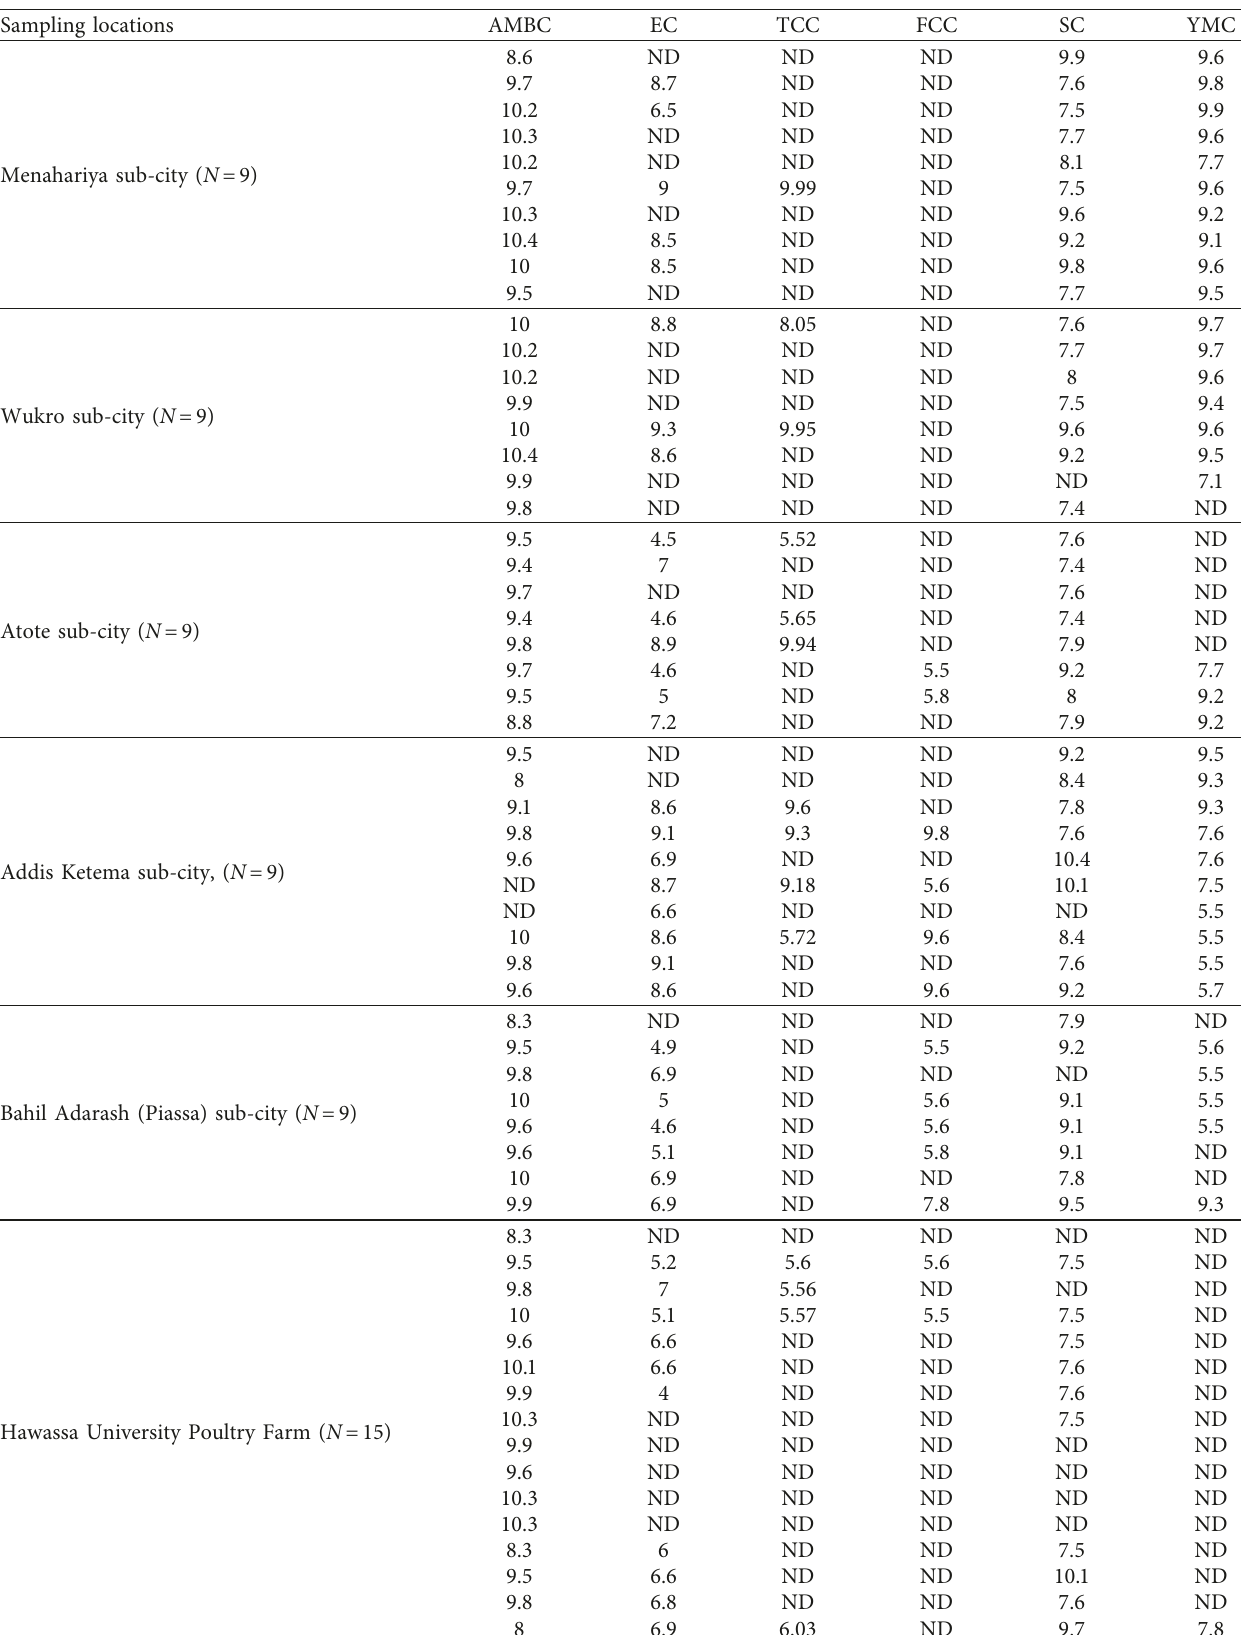
Table 4: Mean microbial loads in log 10 CFU/ml of the contents of chicken egg samples collected from six different locations in Hawassa City, southern Ethiopia, 2019. Sampling locations AMBC EC TCC FCC SC YMC